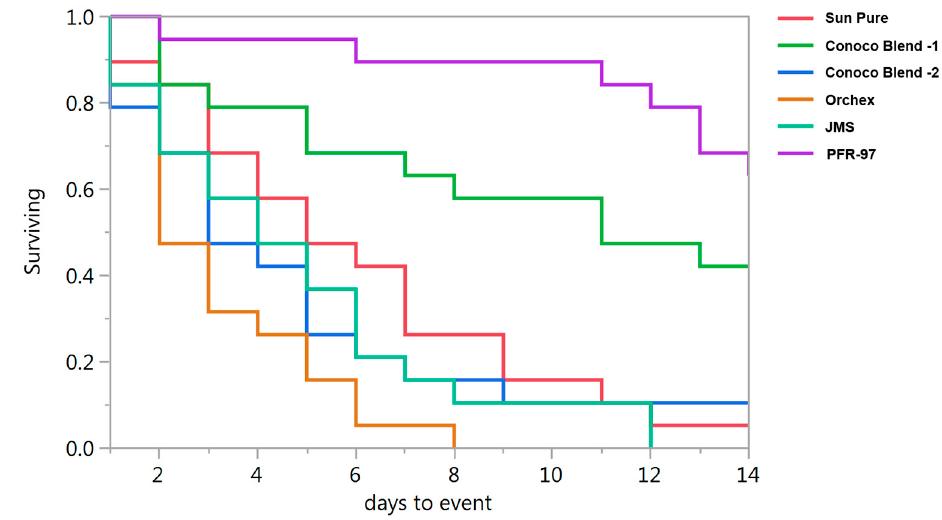
Figure 2. Survival curves for Diaphorina citri adults after being exposed to Isaria fumosorosea (PFR-97) alone or mixed with different HMOs.